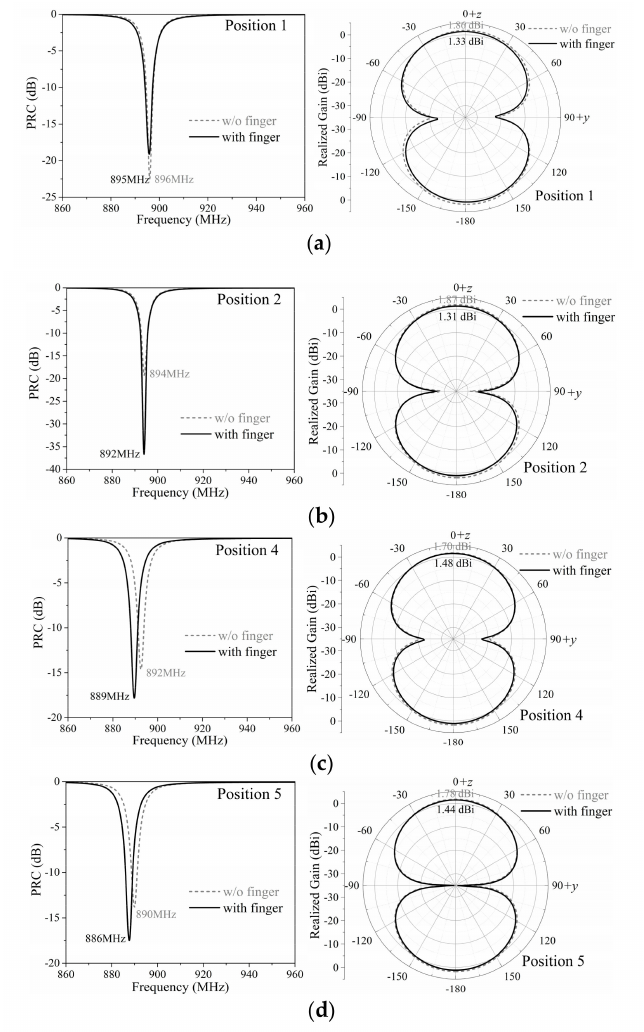
Figure 10. Simulated PRC and radiation patterns in the vertical plane (y–z plane) of the activated tag at ( a ) position 1, ( b ) position 2, ( c ) position 4, and ( d ) position 5 with / without the impact of the